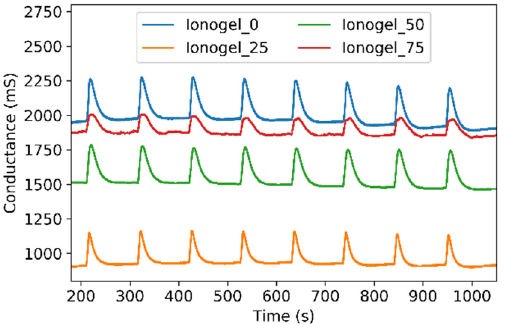
Figure 3. Response of set A sensors to eight exposure (5 s)/recovery (100 s) cycles to ethanol vapors, doped with different concentrations of Fe 3 O 4 : (blue) pure ionogels, (orange) 25 mg/mL, (green) 50 mg/mL and (red) 75 mg/mL.